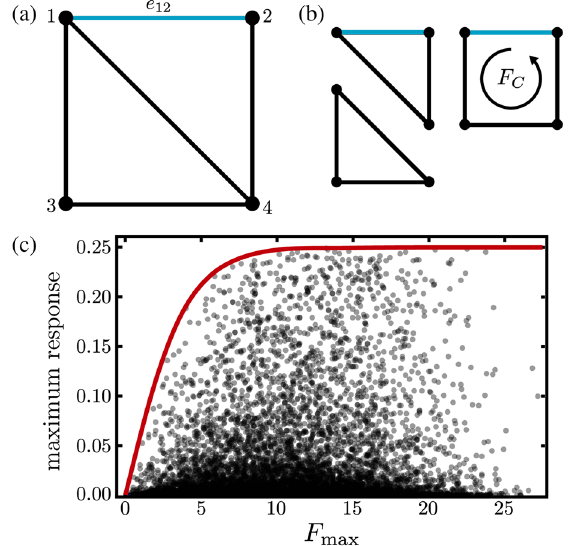
FIG. 3. Thermodynamics and topology bound response. (a) Transition graph for our representative four-state system with a single perturbed edge connecting states 1 and 2, e 12 , highlighted in blue. (b) Only cycle forces F C around cycles that contain the perturbed edge e 12 , highlighted in blue, constrain the static response. (c) The maximum response max j j ∂ π j = ∂ B 12 j to the perturbation of the edge parameter B 12 as a function of the maximum cycle force around cycles containing e 12 for 15 000 randomly sampled rate matrices (gray dots). All samples fall = 4 Þ (red below the predicted bound ð 1 = 4 Þ tanh ð F max